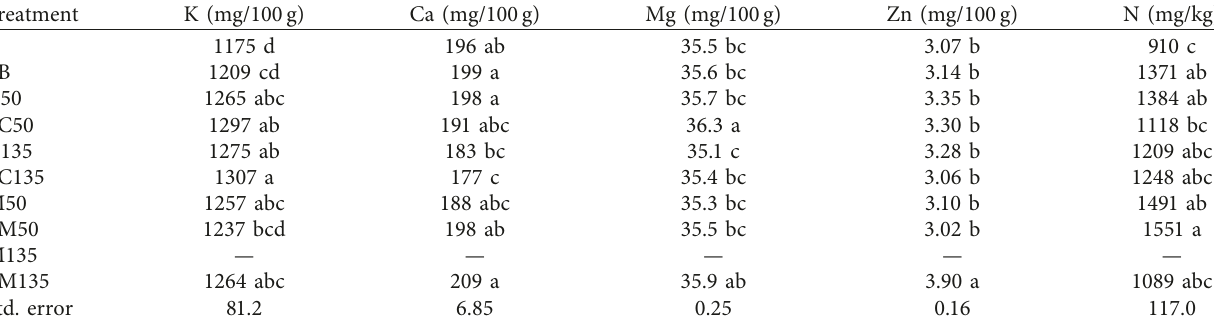
Table 4: Elemental concentrations of kale leaves at time of harvest.